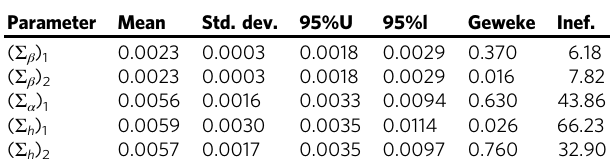
Table 5 Parameter estimation and test. Parameter Mean Std. dev. 95%U 95%l Geweke